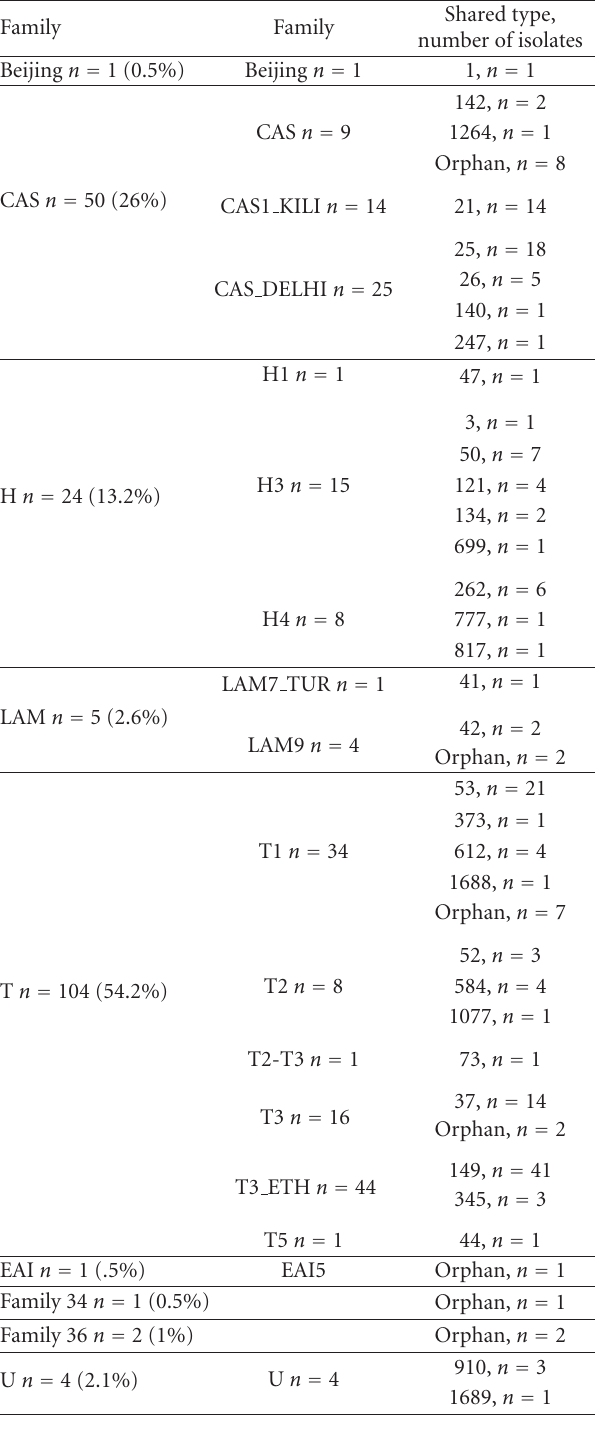
Table 1: Family and family distribution and associated ST for each isolate in the study.